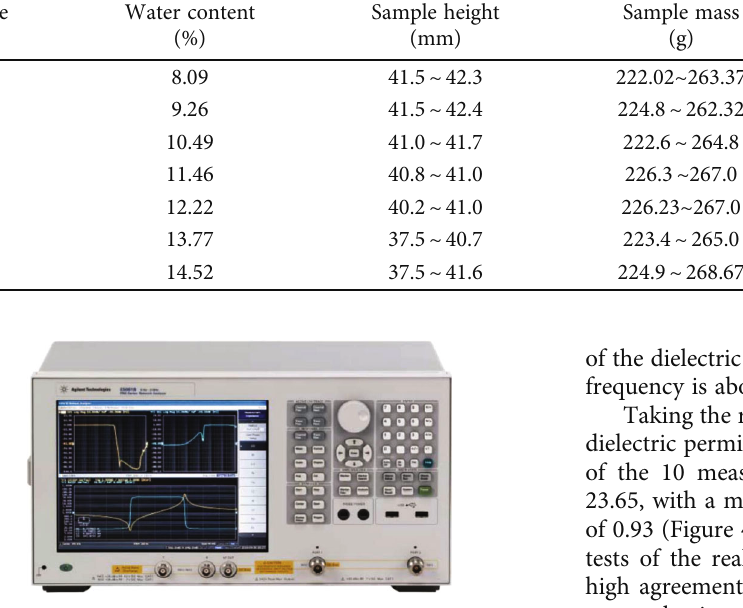
Figure 1: E5061B Network analyzer.